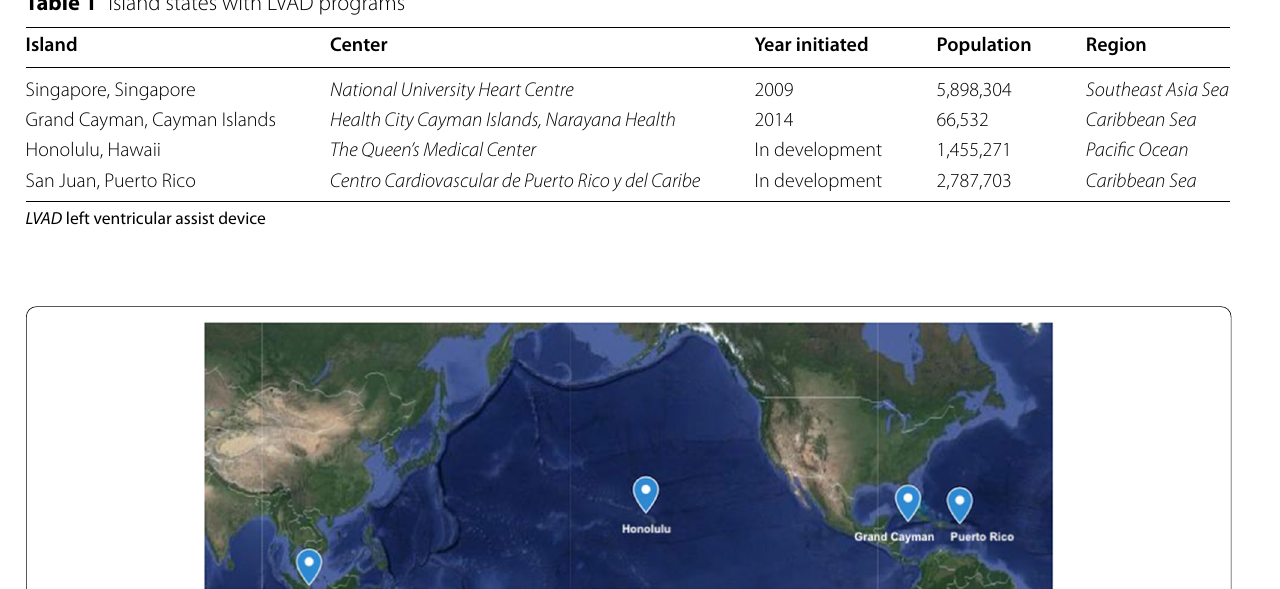
Table 1 Island states with LVAD programs